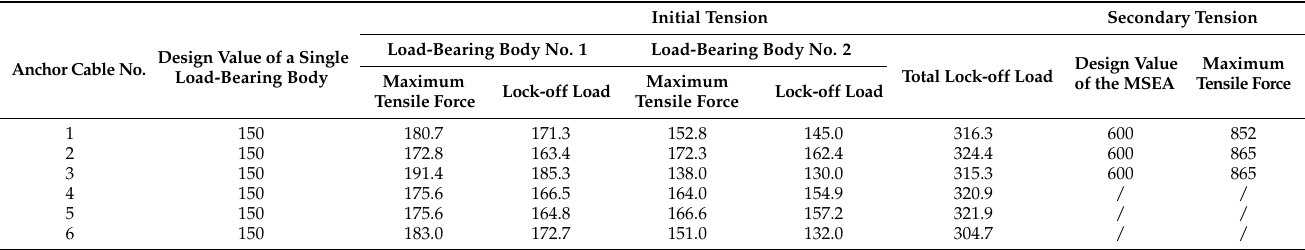
Table 1. Field test results of the MSEAs